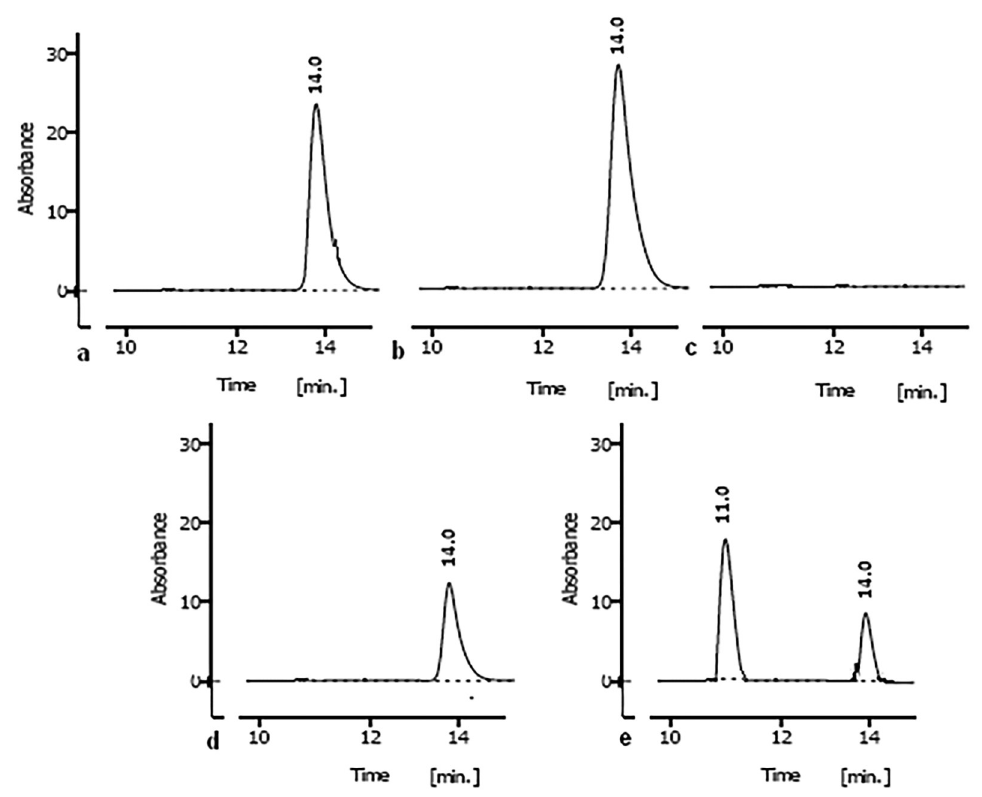
FIGURE 2 - Results of specificity study (a: chromatogram of raw material sample; b: chromatogram of Tilo ® tablets sample; c: chromatogram of placebo sample; d: chromatogram of Tilo ® tablets sample in NaOH 1 mol/L, 70 °C during 72 hours and e: chromatogram of Tilo ® tablets sample at 30% H O solution during 24 2 2